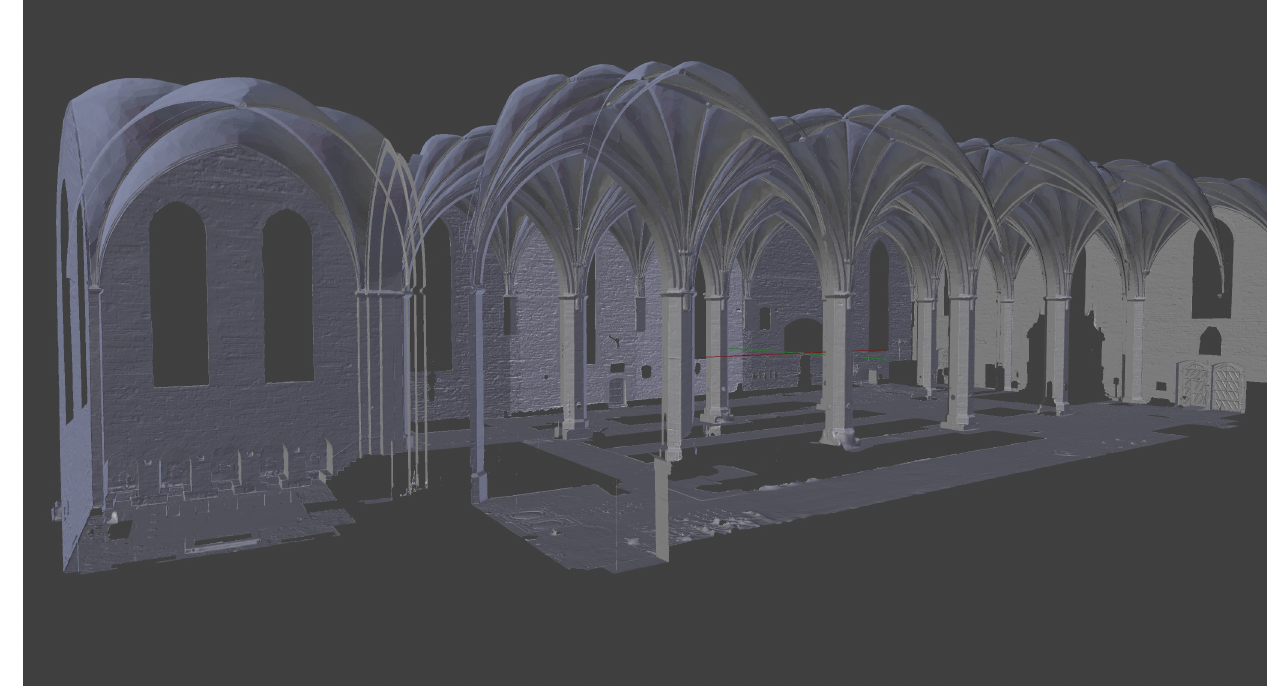
Figure 2. 3D scan showing only the church’s original 15th century parts. View to the north, with the chancel and the location of the monks’ choir to the west, on the